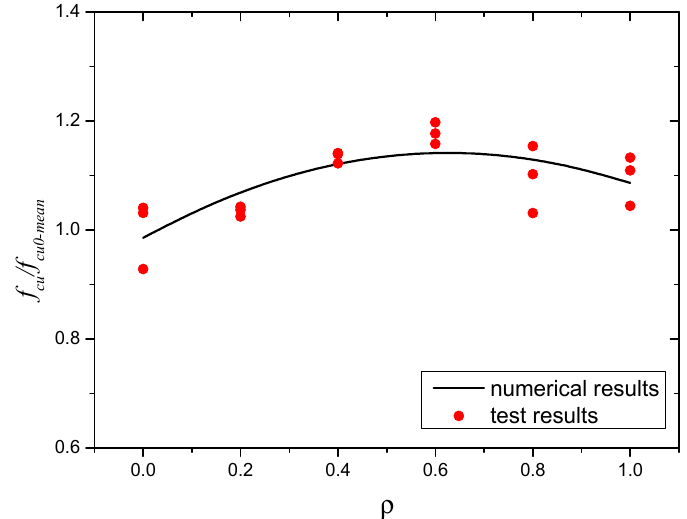
Figure 10. Comparison between numerical and test results: f cu .